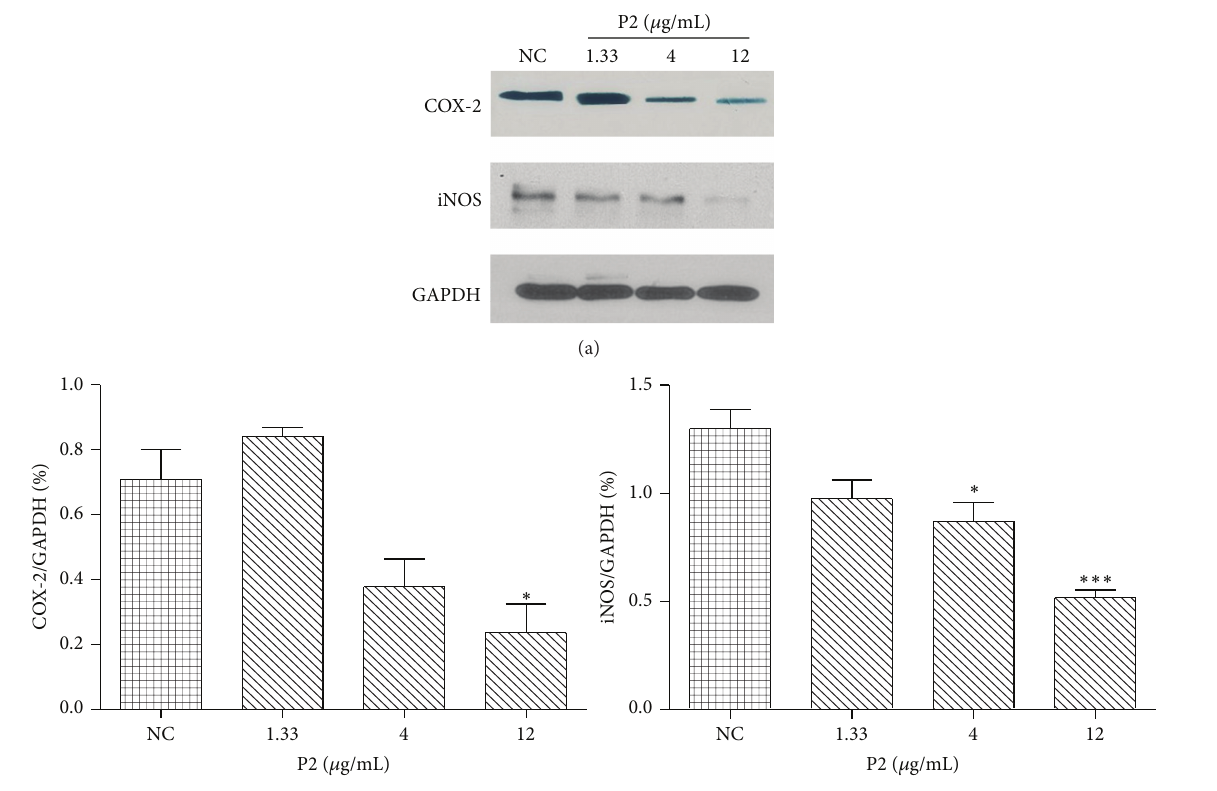
Figure 4: (a) Effects of P2 on immune-related proteins expression in HeLa cells. Following treatment with P2 (1.33, 4, 12 𝜇 g/mL), whole lysates were collected and analyzed by western blotting with antibodies specific for COX-2 and iNOS. GAPDH was used as an internal control. Results are representative of three independent experiments. (b) Quantification of expression levels by western blotting. The inhibition of COX-2 and iNOS were 78.67% and 69.65% for the high concentration, respectively, after treatment with P2. GAPDH was used as an internal control. ∗ 𝑃 < 0.05 and ∗∗ 𝑃 < 0.01 compared with NC. The results are representative of three independent experiments and expressed as mean ± SD. Differences were defined as significant at 𝑃 < 0.05